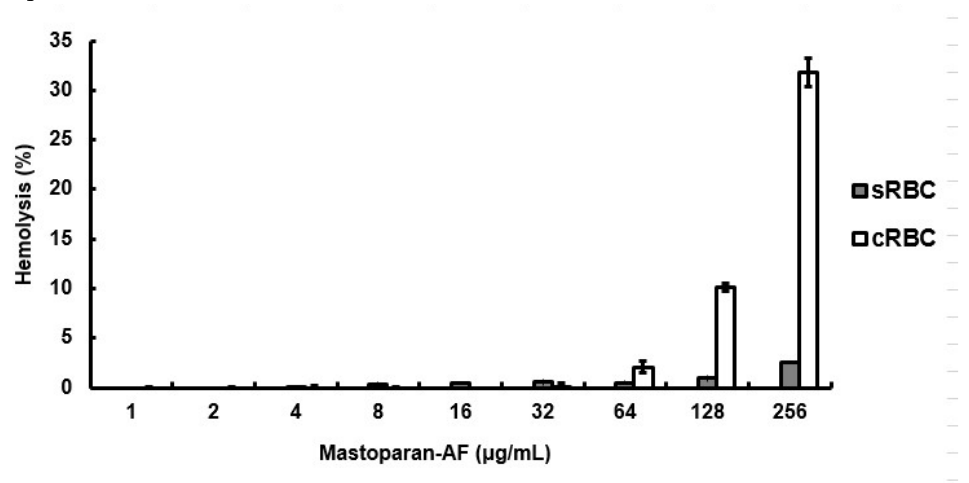
Figure 3. Hemolytic activity of mastoparan-AF on RBCs. The hemolytic activity was assayed in sheep RBC (sRBC) and chicken RBC (cRBC). The absorbance values measured at 570 nm from the supernatant of lysed RBC in the presence of PBS and 0.1% Triton X-100 were determined as 0 and 100% hemolysis, respectively. Results were expressed as means ± SD ( n = 4).